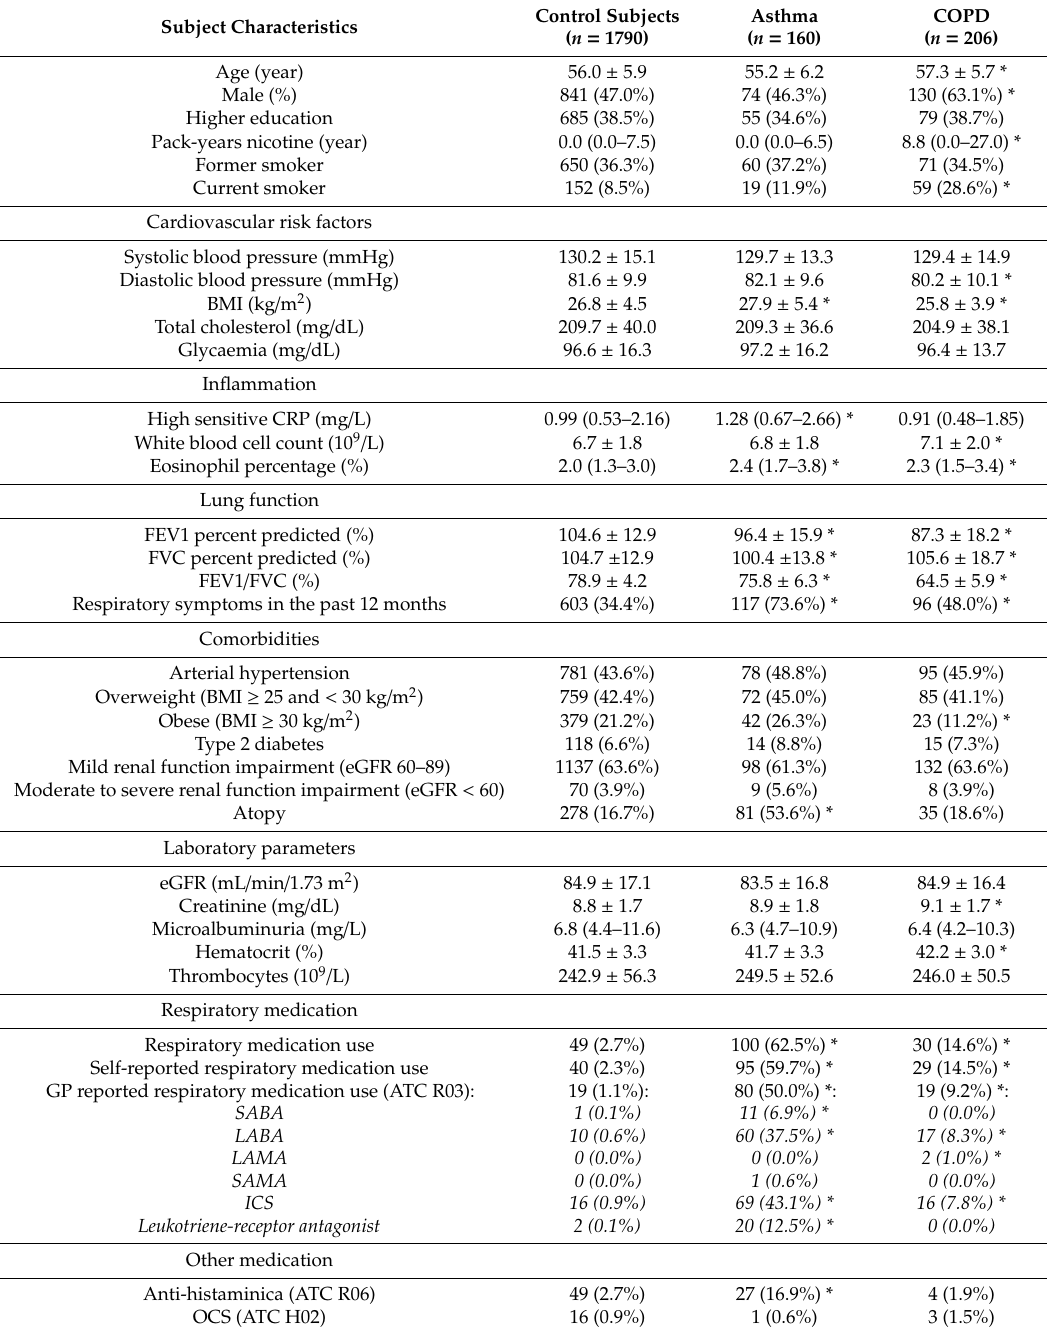
Table 1. Baseline characteristics of subjects in the Asklepios